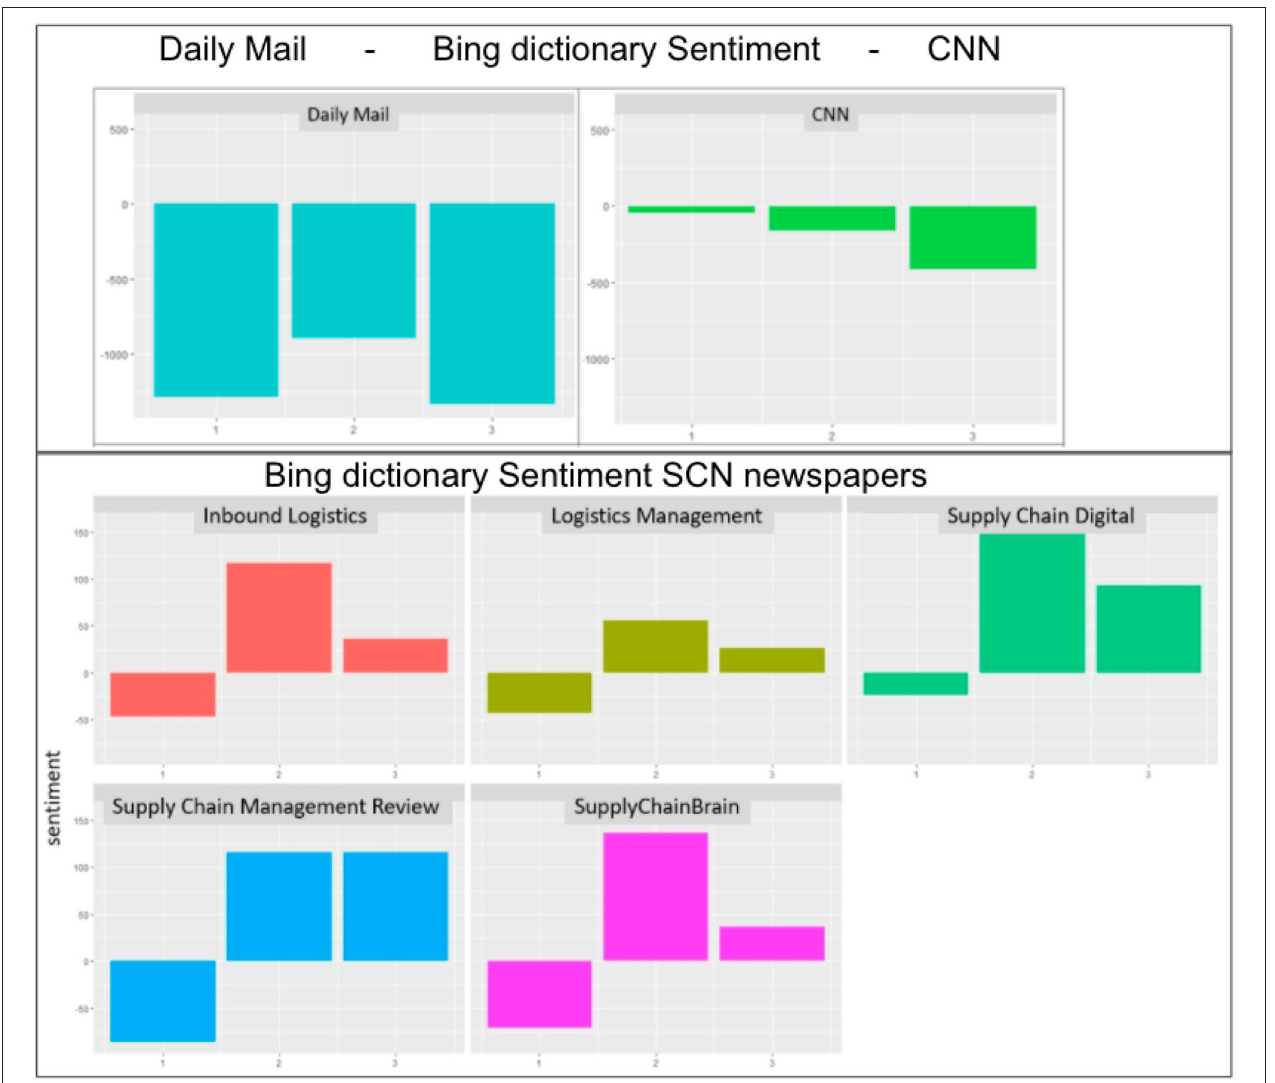
FIGURE 4 | Bing dictionary sentiment GN and SCN across time frames (for more breakdowns per Newspaper, see Annex 5_4.2 _Additional